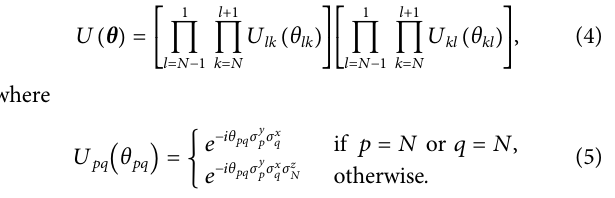
Frontiers in Physics |